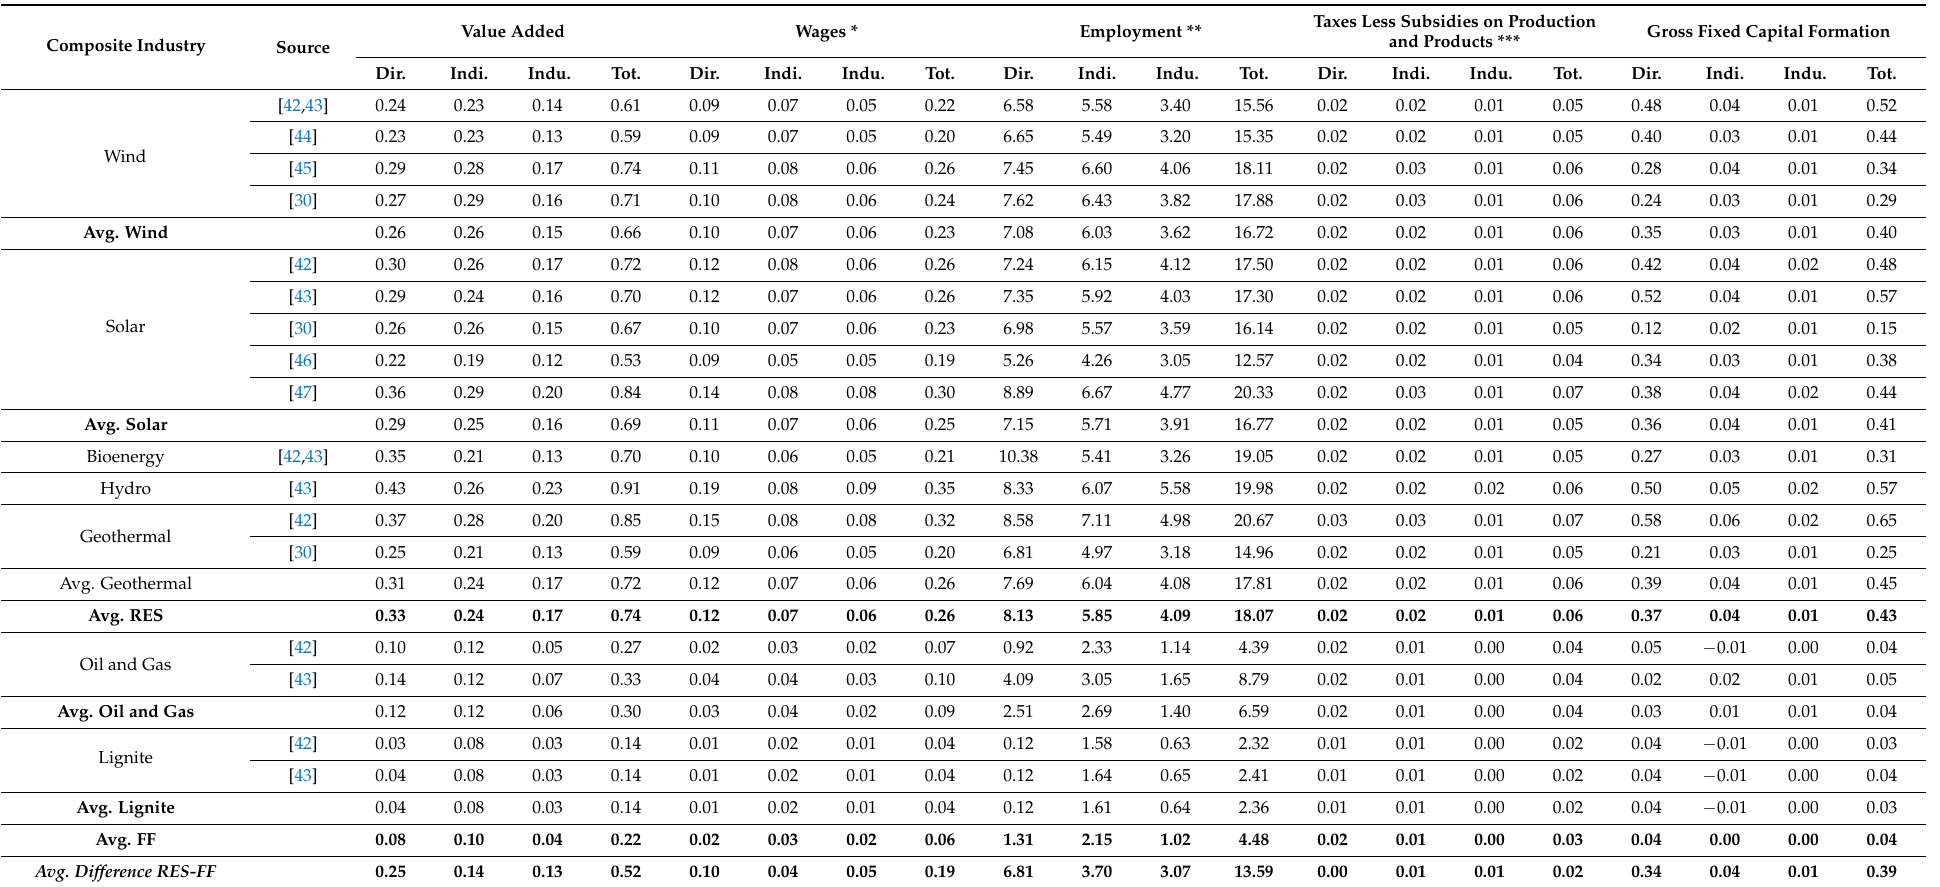
Table 7. Multiplier effects for each RES-type deployment by EUR 1 million spent on the output of their corresponding synthetic industry, by economic aspect, effect type, and initial demand vector formation from the